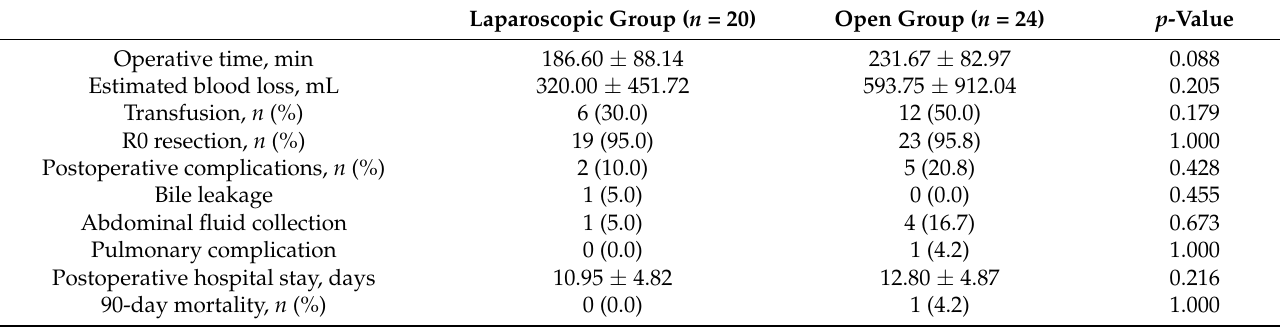
Table 2. Comparison of operative outcomes in laparoscopic and open